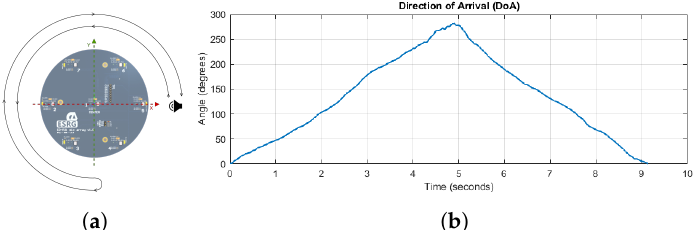
Figure 12. Moving sound pattern and respective calculated DoA. ( a ) Sound source path. ( b ) Direction of arrival of a sound source over the time.